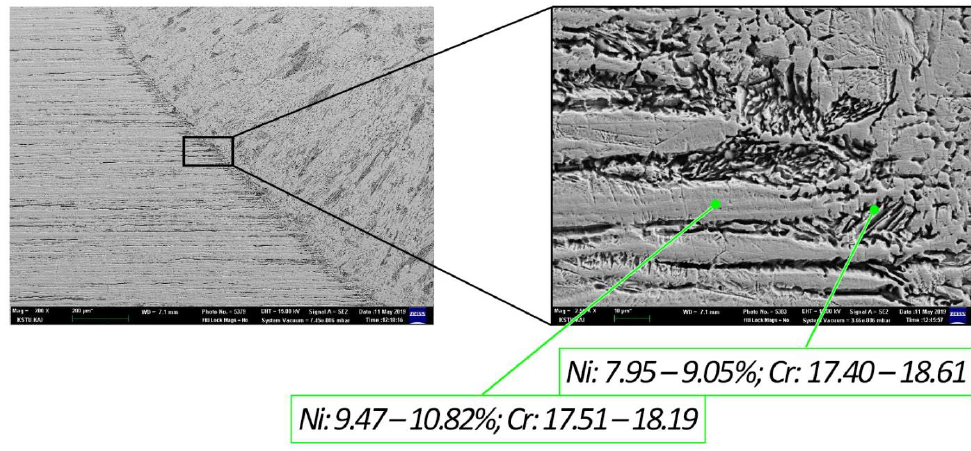
Figure 5. SEM images of a NHT sample. Materials 2019 , 12 , x FOR PEER REVIEW